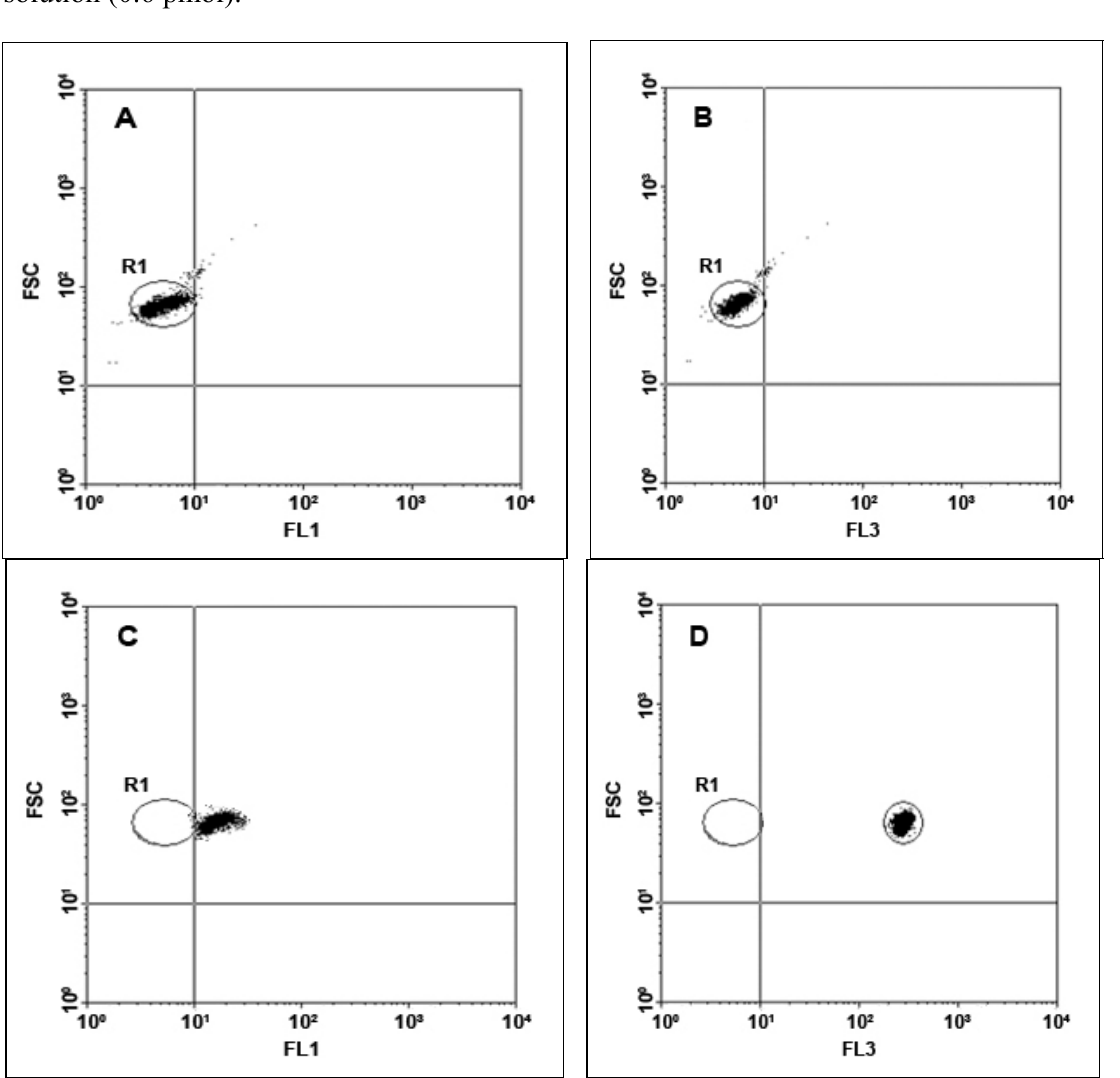
Figure 4. Flow cytometric analysis of bead-fluorophore complexes. A; Unlabelled beads on a dot-plot of FL1 (x-axis) versus FSC (y-axis) were positioned within the first decade of fluorescence. B: Unlabelled beads on a dot-plot of FL3 (x-axis) versus FCS (y-axis) were also positioned within the first decade. C: LinkerFITC-bead complexes on a dot-plot of FL1 (x-axis) versus FSC (Y-axis) at a concentration of 0.6 pmol of LinkerFITC. D: QDs- bead complexes observed on a dot-plot of FL3 (y-axis) versus FSC (y-axis) at a concentration of 0.6 pmol of QDs showed increased intensities over FITC. E: A histogram of the fluorescent intensity for QD-beads (blue line) and LinkerFITC-beads (black line) complexes versus unlabeled beads (red line) at the same fluorophore concentration in solution (0.6